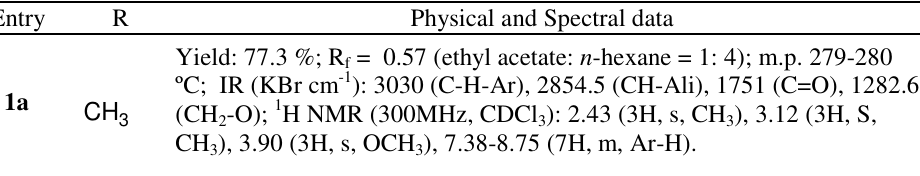
Table 1 . Physical and spectral data of synthesized compounds ( 1a - h